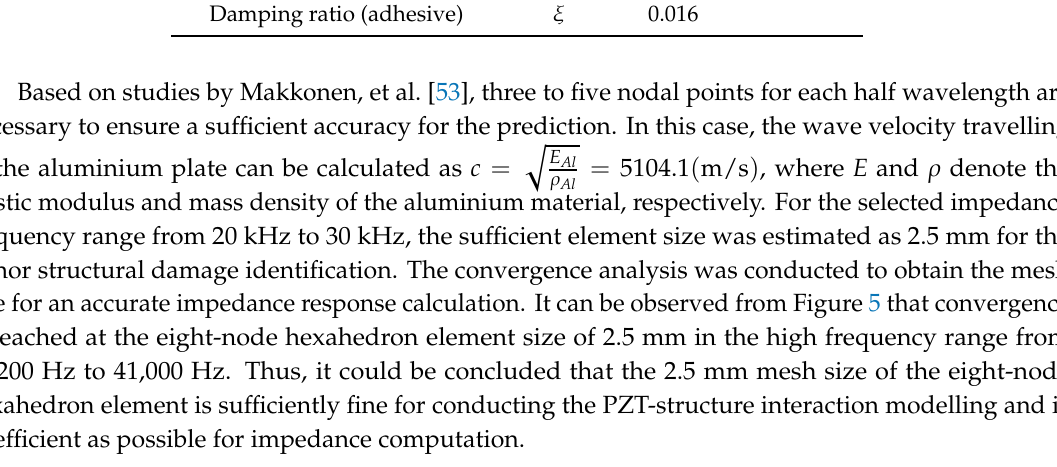
Table 3. Modified parameters of piezoelectric material in finite element modelling.